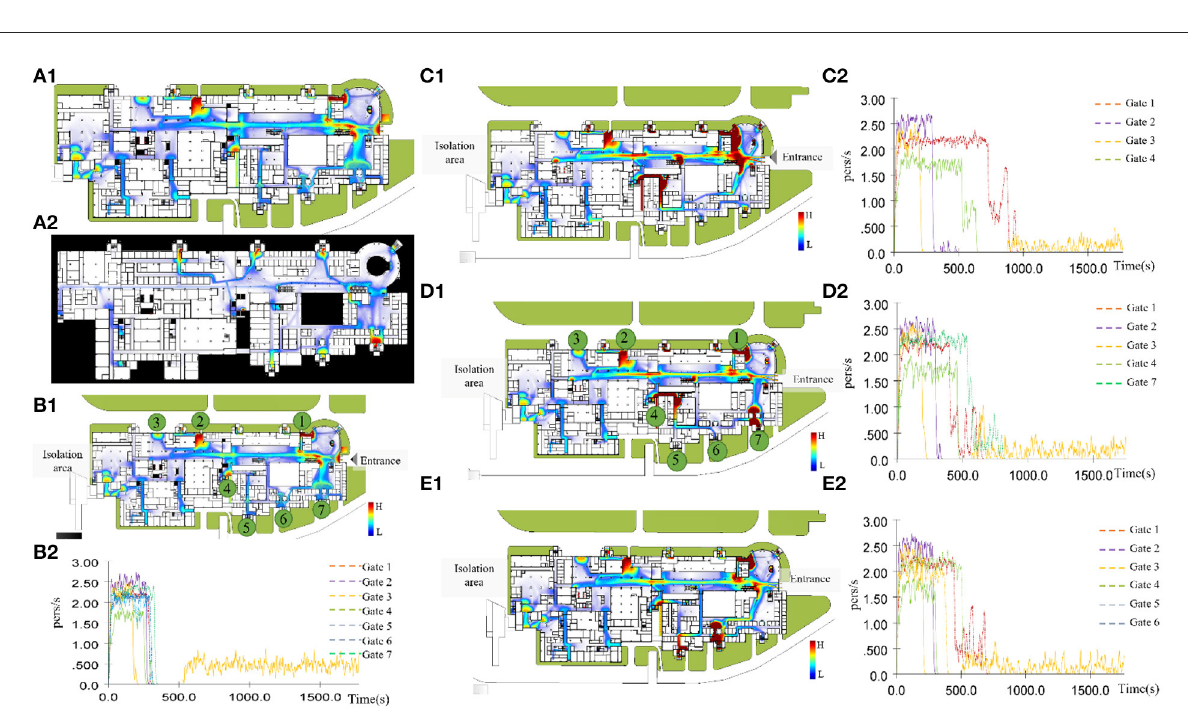
FIGURE2 Simulation of flow distribution on the first and third floors, under daily conditions. (A) The main entrances, lobby corridor, elevators, and exits had a relatively dense flow distribution; (B) All entrances and exits open; (C) Entrances no. 5/6/7 and exits closed; (D) Entrances no. 5/6 closed and entrance no. 7 open; (E) Entrances no. 5/6 open and entrance no. 7